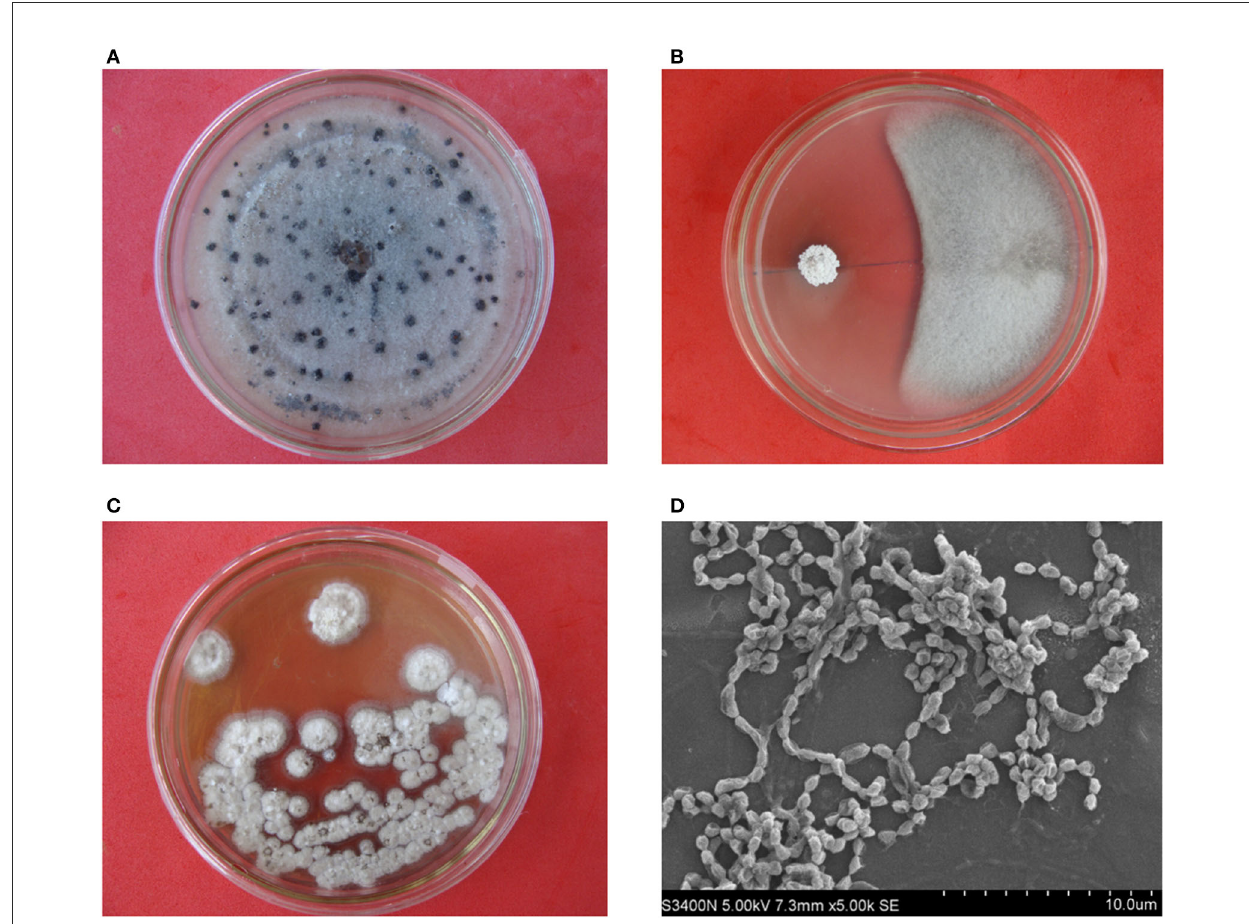
FIGURE1 Antifungal activity of strain HNM0140 T against C. gloeosporioides on a PDA plate and morphological features of HNM0140 T colonies and spore chains. (A) C. gloeosporioides growth without antagonist challenge. (B) Inhibition of C. gloeosporioides growth by strain HNM0140 T . (C) Morphological features of strain HNM0140 T colonies. (D) Scanning electron micrograph showing spore chains of strain HNM0140 T